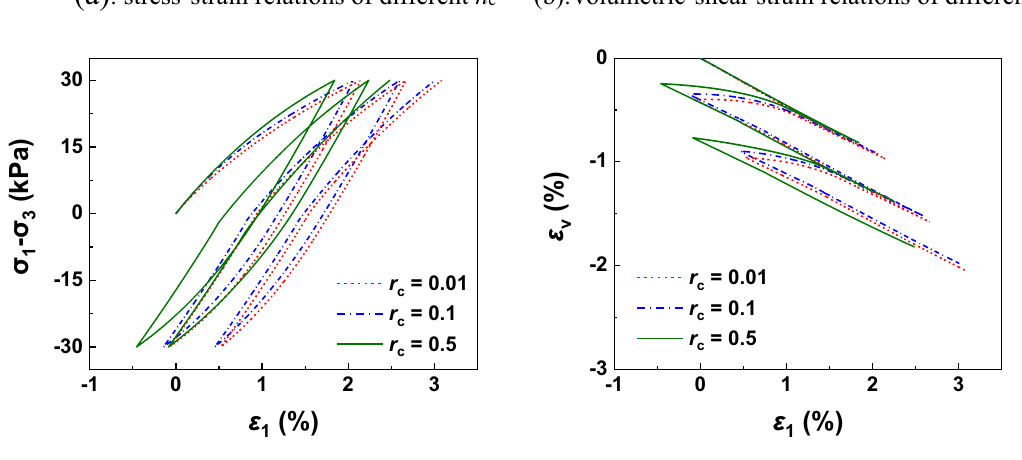
Jiangxi clay Boston blue clay Toyoura